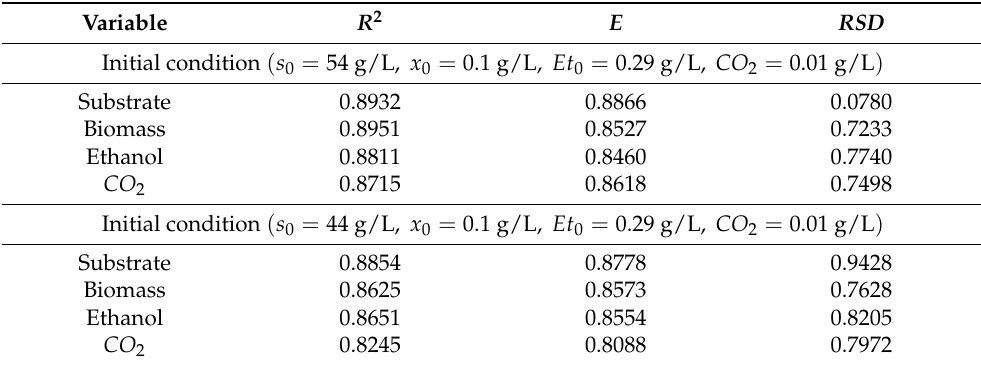
Table 3. Statistical correlation coefficients for quantifying the effectiveness of the model in describing the experimental observations related to discontinuous fermentation.